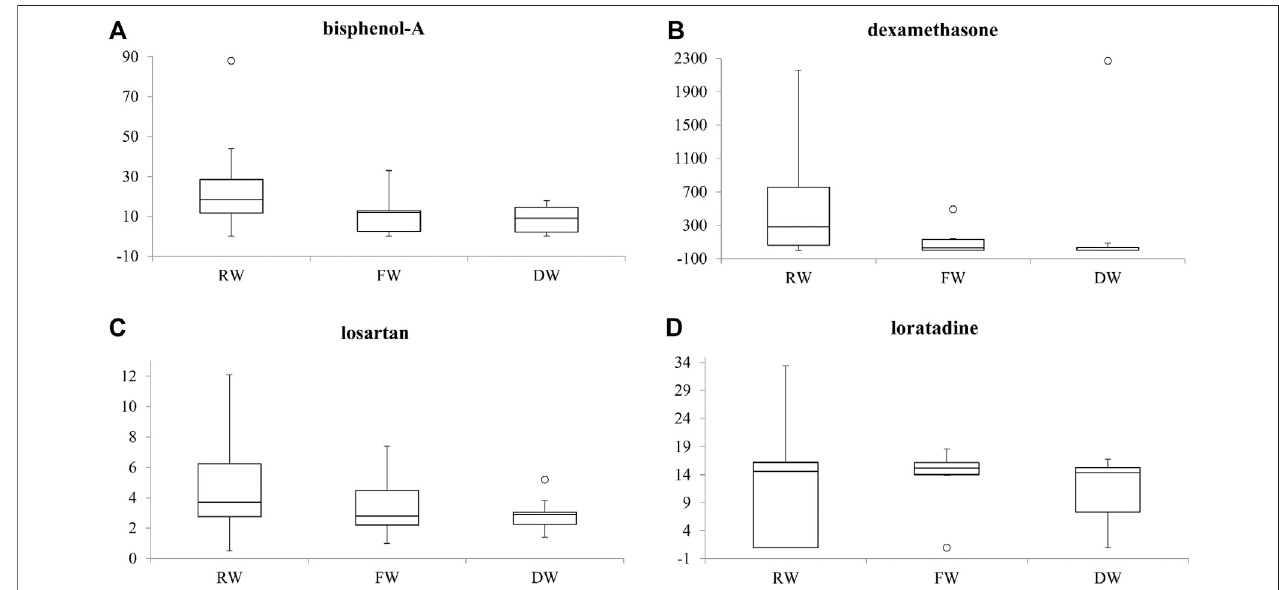
FIGURE 3 | Changes in concentration (ng · L − 1 ) of the compounds most frequently detected in raw water at the WTP-Jataizinho: (A) bisphenol-A, (B) dexamethasone, (C) losartan and (D) loratadine.